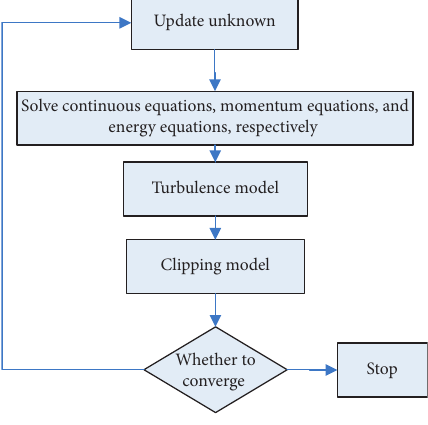
Figure 1: Calculation